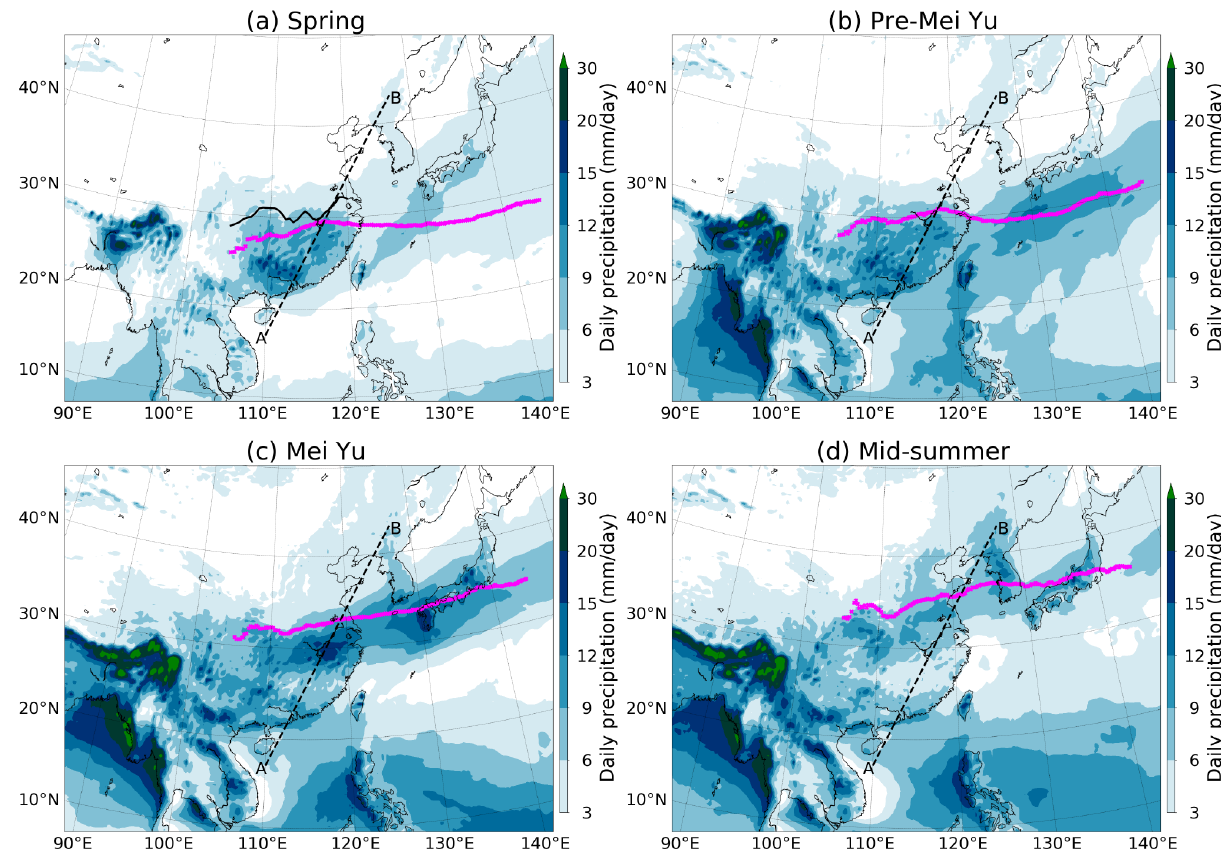
Figure 4. Dekadal mean of daily precipitation (shading; mmd − 1 ). The magenta line indicates the climatology of the mean dekadal location of the EASMF at 850hPa. The AB dashed black line indicates the transect of the vertical cross-section in Fig. 10. The solid black line in panel (a) indicates the middle and lower course of the Yangtze River. The dekads representing the four stages of EASM progression (first dekad of May, first dekad of June, third dekad of June, second dekad of July, respectively) are selected according to Fig. 3. Data from ERA5 1979–2018